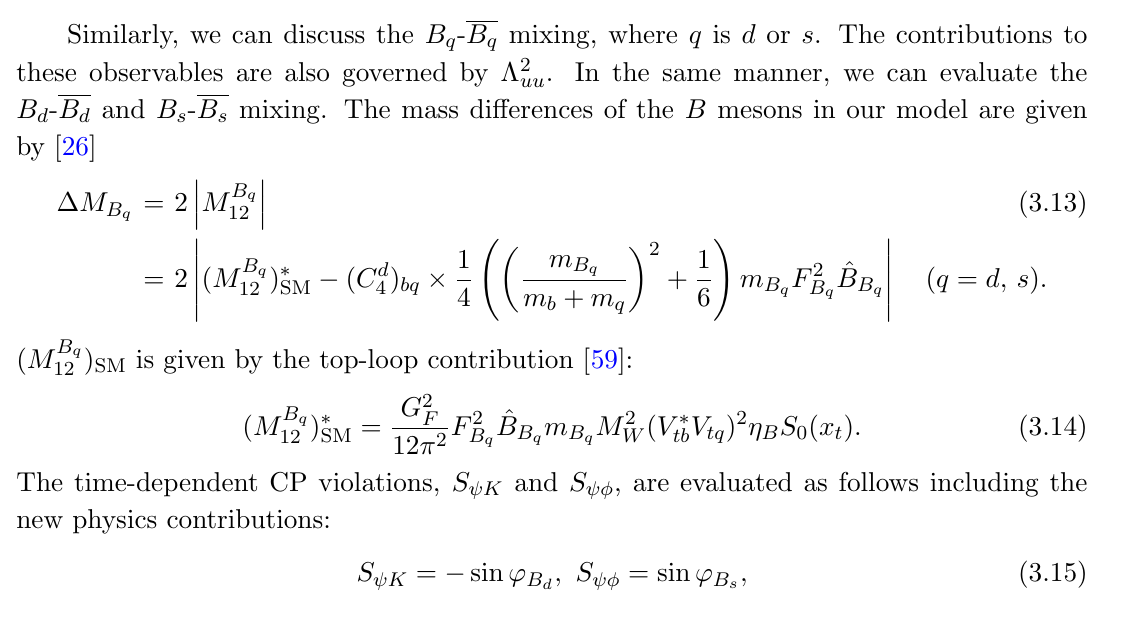
Table 3 . The input parameters in our analysis. The CKM matrix, V , is written in terms of (cid:21) , A , (cid:26) and (cid:17)